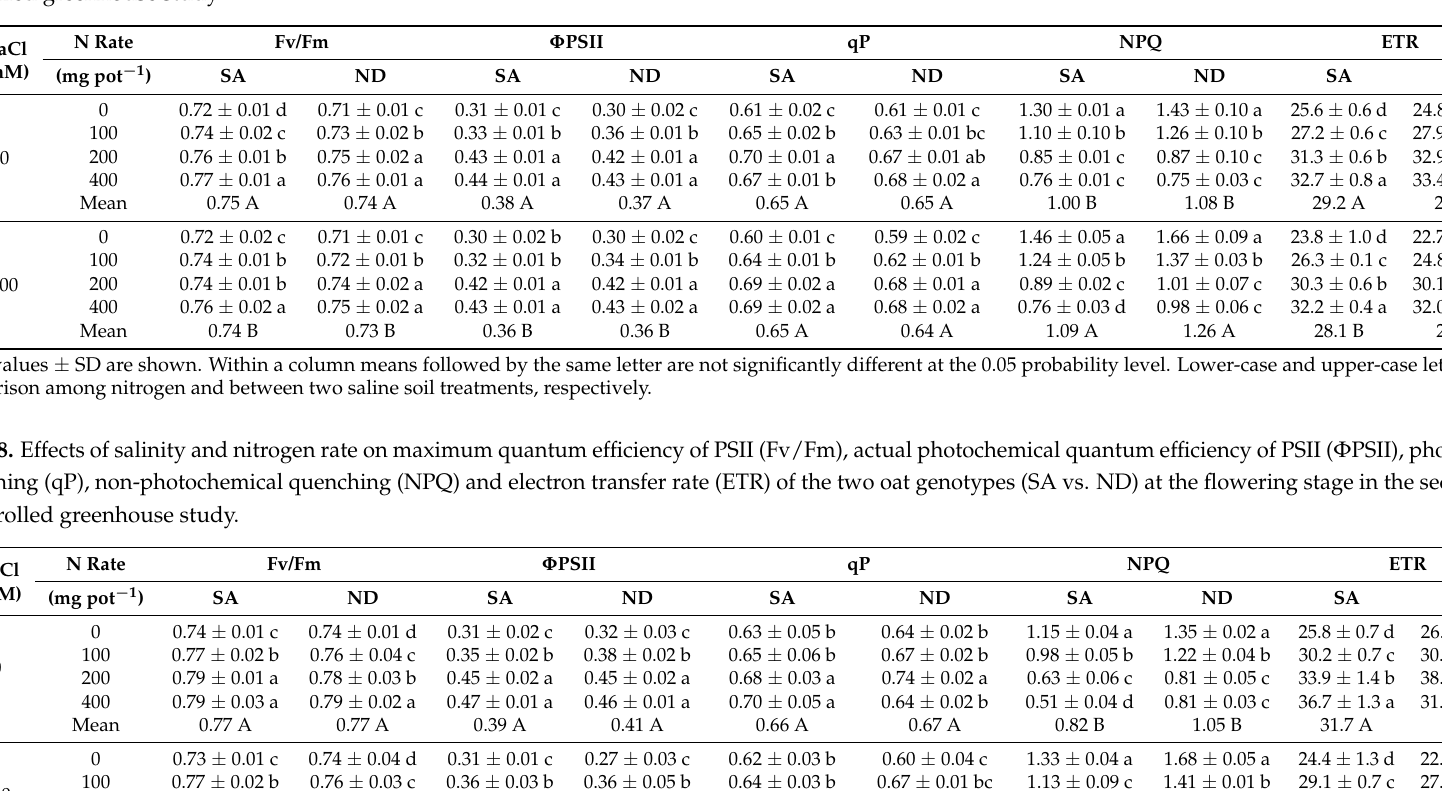
Table 7. Effects of salinity and nitrogen rate on maximal quantum yield of PSII (Fv/Fm), actual photochemical quantum efficiency of PSII ( Φ PSII), photochemical quenching (qP), non-photochemical quenching (NPQ) and electron transfer rate (ETR) of the two oat genotypes (SA vs. ND) at the flowering stage in the first run of a